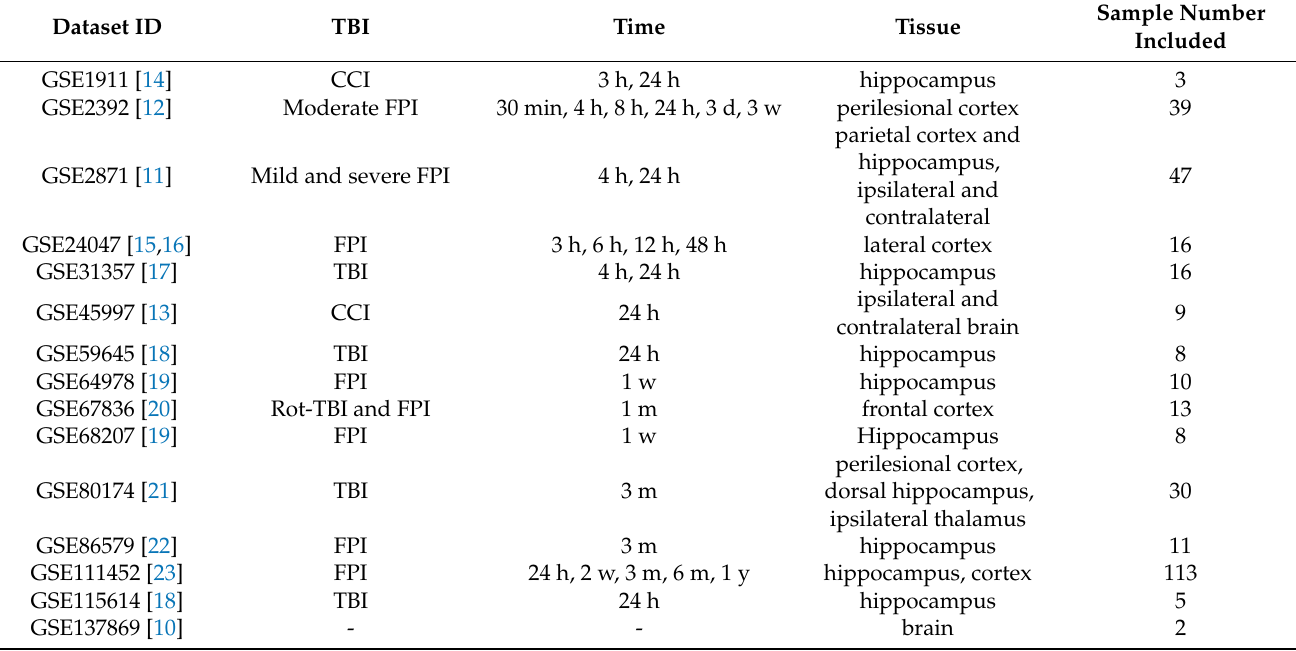
Table 1. GSE databases included in the